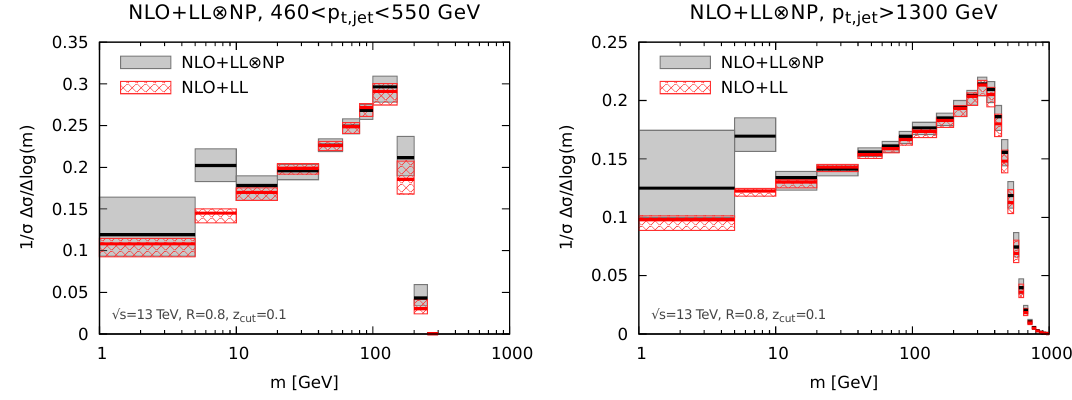
Figure 12 . Final results at NLO+LL, with non-perturbative corrections, for the normalised jet mass distribution, in the case of the ungroomed p t; jet